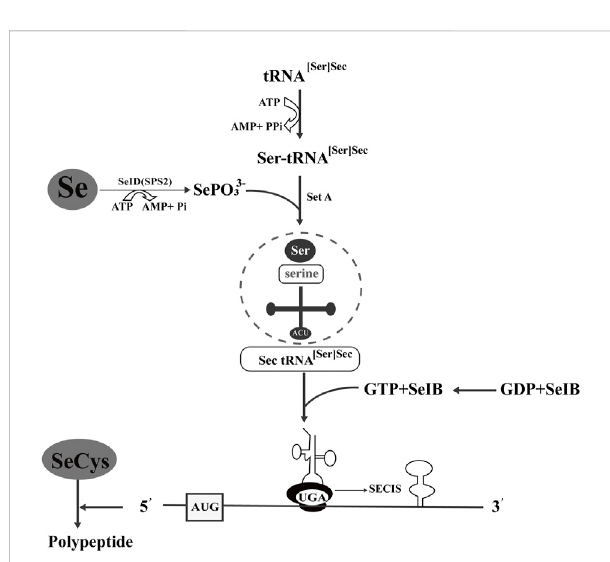
Synthesis and incorporation of selenocysteine in prokaryotes. tRNA [Ser]Sec carries SeCys and recognizes the codon of UGA. Ser- tRNA [Ser]Sec is involved in SeCys biosynthesis, and selenium phosphate synthase D/selenophosphate synthase 2 (SeID/SPS2) catalyzes selenium to form the selenium donor of monoselenophosphate (MSP). SeIB is a speci fi c translation factor, and its C-terminal amino acid sequence of approximately 270 bp can bind with GU on the top ring of the SeCys insertion sequence (SECIS) step- loop anticodon complementary to UGA. SeCys tRNA is unique in that it controls the expression of the whole selenoprotein family (Leinfelder et al., 1988). Unlike the other 20 amino acids in the genetic code,